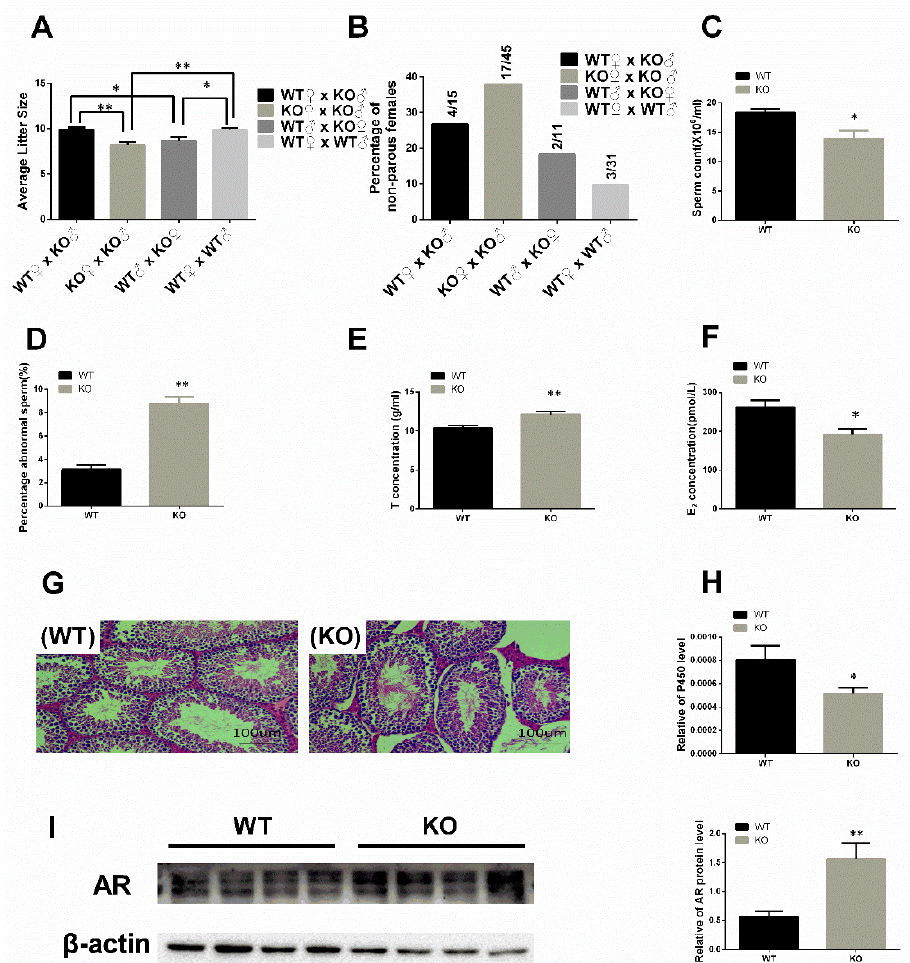
Figure 2. miR-125b-2 knockout causes different reproduction phenotypes. ( A , B ) The effect of miR-125b-2 knockout on the fertility of male mice. WT and KO males were examined in the following four combinations: WT ♀ × KO ♂ , KO ♀ × KO ♂ , WT ♂ × KO ♀ , and WT ♀ × WT ♂ . The pups ( A ) and litter rate ( B ) were counted ( n = 15 – 20). ( C – D ) Effect of miR125b-2 on sperm count ( C ) and percentage of abnormal sperms ( D ) ( n = 8). T (testosterone) concentration ( E ) and E 2 (estradiol) concentration ( F ) in nine-week-old WT and KO mice ( n = 8). ( G ) Microscopic observations of seminiferous tubules in WT and KO mouse testes: a — wild-type FVB/NJ (FVB) male with normal spermatogenesis; b — KO FVB/NJ male (recipient strain). ( H ) P450 expression in mouse testis in KO mice ( n = 8). ( I ) Characterization of androgen receptor (AR) protein and gray-scale scanning analyses in WT and KO mouse testis ( n = 4). All of the data were expressed as mean ± SEM. * p < 0.05, ** p < 0.01.